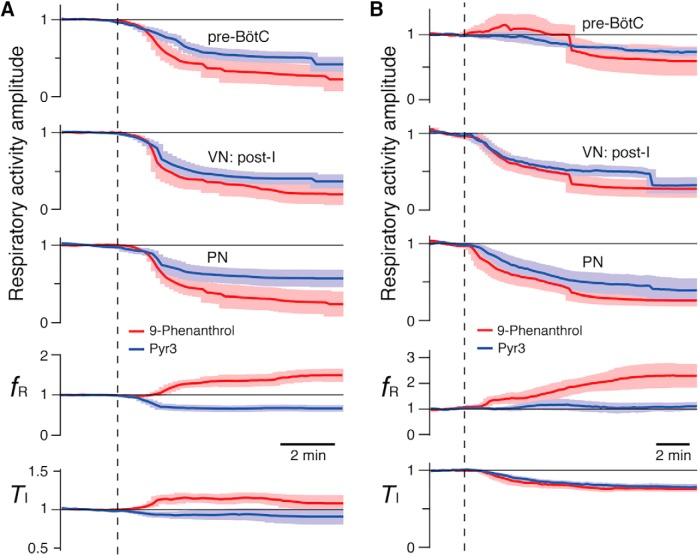
Summary of effects of TRPM4 and TRPC3 channel inhibitors on respiratory activities in arterially perfused brainstem–spinal cord preparation in situ from mature rats and adult mice. A, B, Summary time courses (solid lines: mean values; lighter color bands: ± SEM) of the amplitudes of integrated inspiratory pre-BötC neural population activity, VN post-inspiratory (post-I) activity, and PN inspiratory activity from rat (A, 9-phenanthrol, n = 6; Pyr3, n = 8) and mouse (B, 9-phenanthrol, n = 7; Pyr3, n = 6) preparations, showing significant reduction of all amplitudes (normalized to mean control values) by both TRPM4 (9-phenanthrol, red) and TRPC3 (Pyr3, blue) channel inhibitors. Bottom panels show group summaries for inspiratory frequency (fR) and inspiratory activity time (TI). Time of drug administration (9-phenanthrol, 20–50 µm; Pyr3, 50 µm) is indicated by vertical dashed lines.